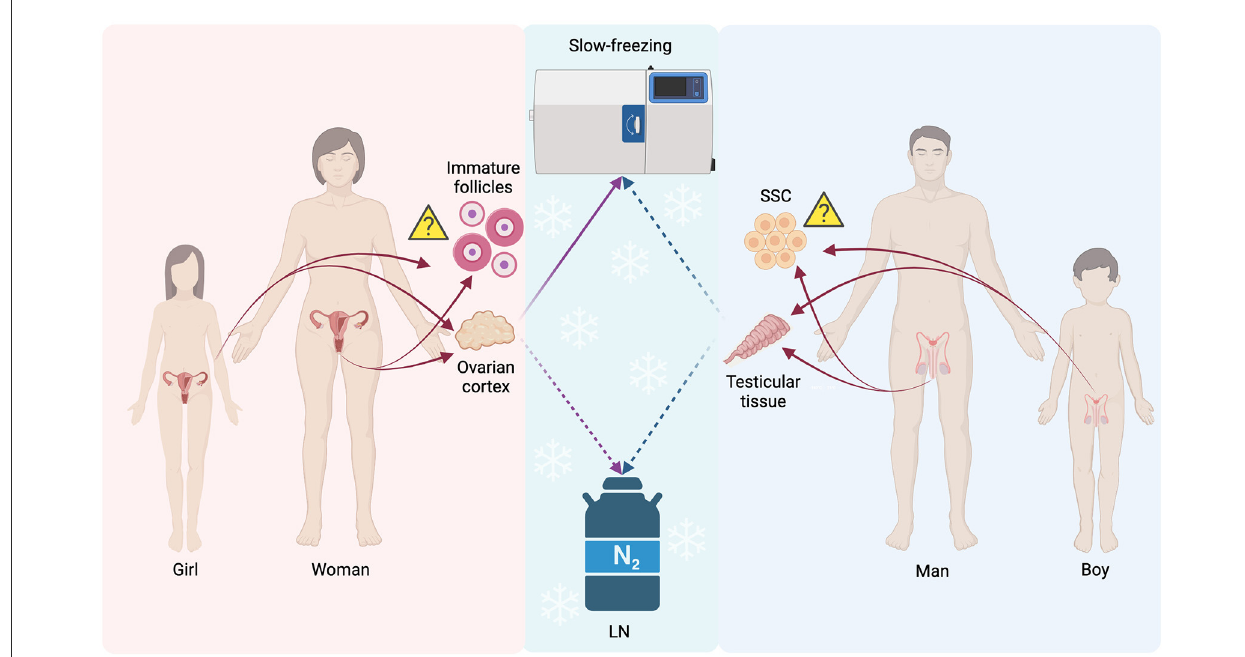
FIGURE2 Schematic representation of the main not routinely applied procedures for FP: gonadal tissues, follicles, and spermatogonial stem cells. LN, Liquid Nitrogen; SSC, spermatogonial stem cells; Solid lines, often used procedure; Dashed lines, not often used procedures/experimental; Triangle, still undecided if feasible for FP purposes or not. The figure was realized with